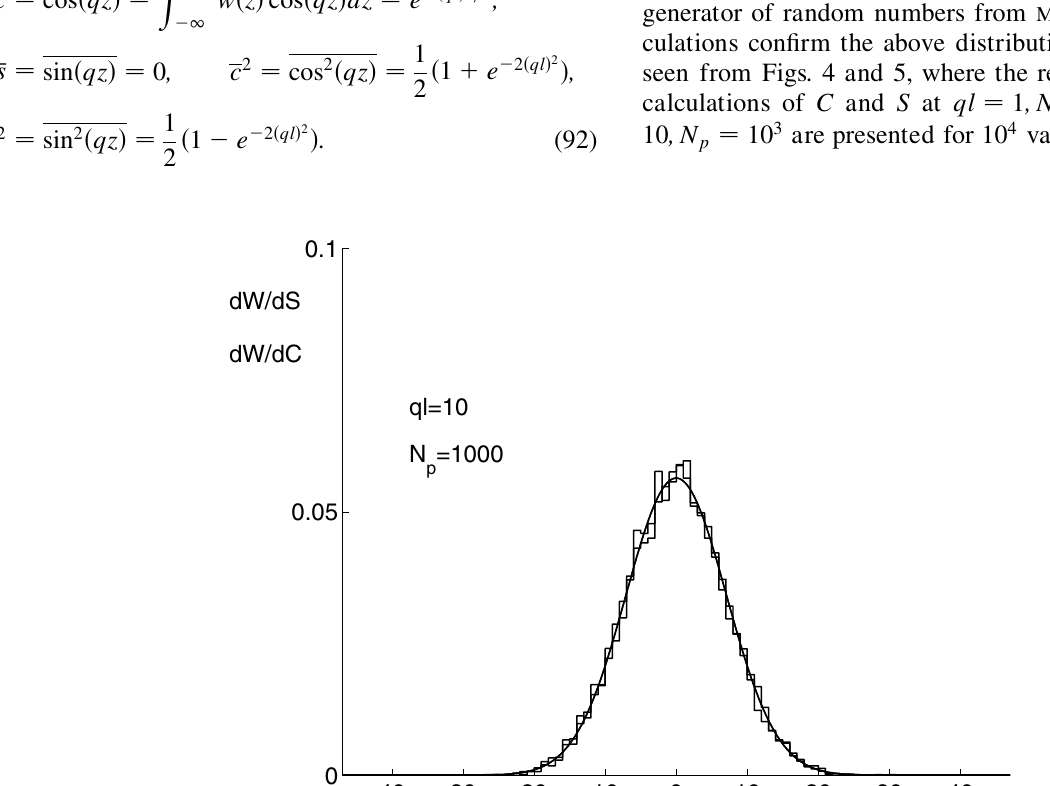
(cid:7) 10 2 . The histograms represent results of numerical p =l g a